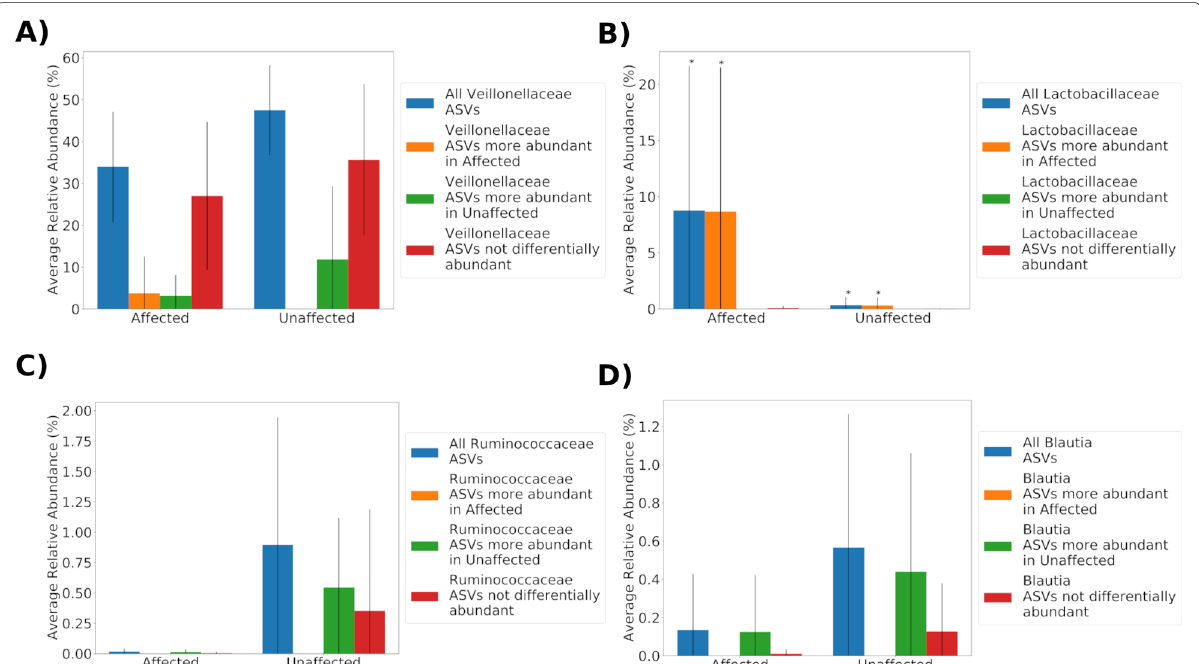
Fig. 6 The average relative abundance of ASVs assigned to single bacterial taxa. The figures show relative abundance of ASVs assigned to bacterial taxa and grouped by classification as not differentially abundant (NDA), more abundant in affected tamarins and more abundant in unaffected tamarins. * indicates where the relative abundance of grouped ASVs was significantly different between unaffected and affected